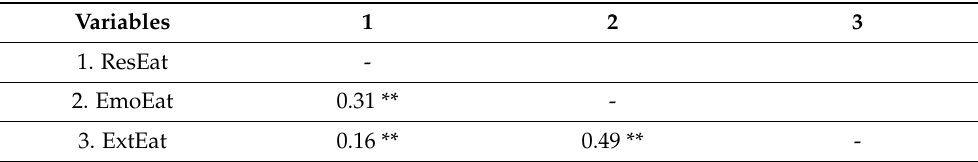
Table 4. Correlations between eating style subscales.